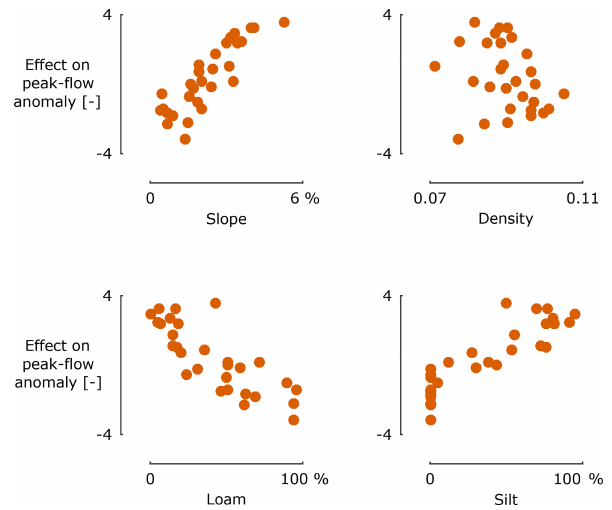
Figure 5. Effect of catchment characteristics on peak-flow anoma- lies for the 29 selected